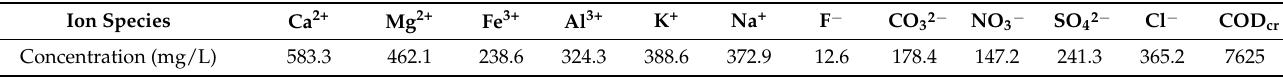
Table 2. Concentrations of coexisting ions and COD cr in HTSS obtained at pH 3. Ion